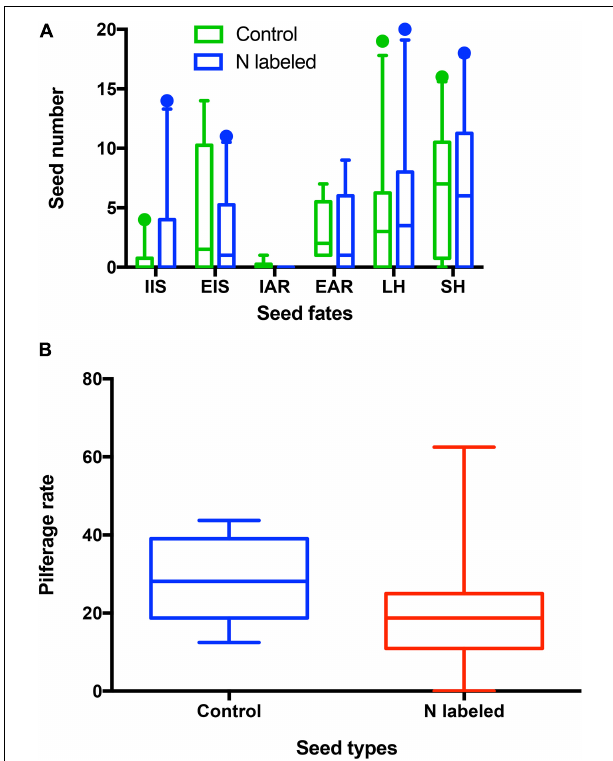
FIGURE 4 | Effects of xylem injection of 15 NH 4 Cl and K 15 NO 3 on seed fates (A) and pilferage rate (B) of Quercus variabilis manipulated by Leopoldamys edwardsi in the enclosures. IIS, EIS, EAR, IAR, and SH stand for seeds intact in situ , eaten in situ , eaten after removal, intact after removal, and scatter-hoarded,